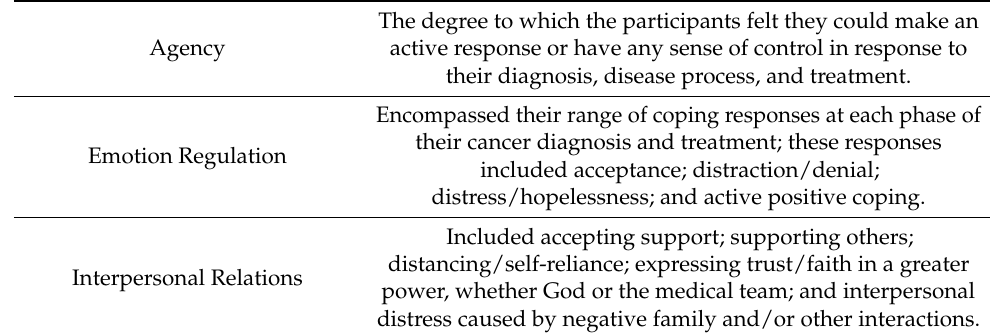
Table 2. Codes of manual system.